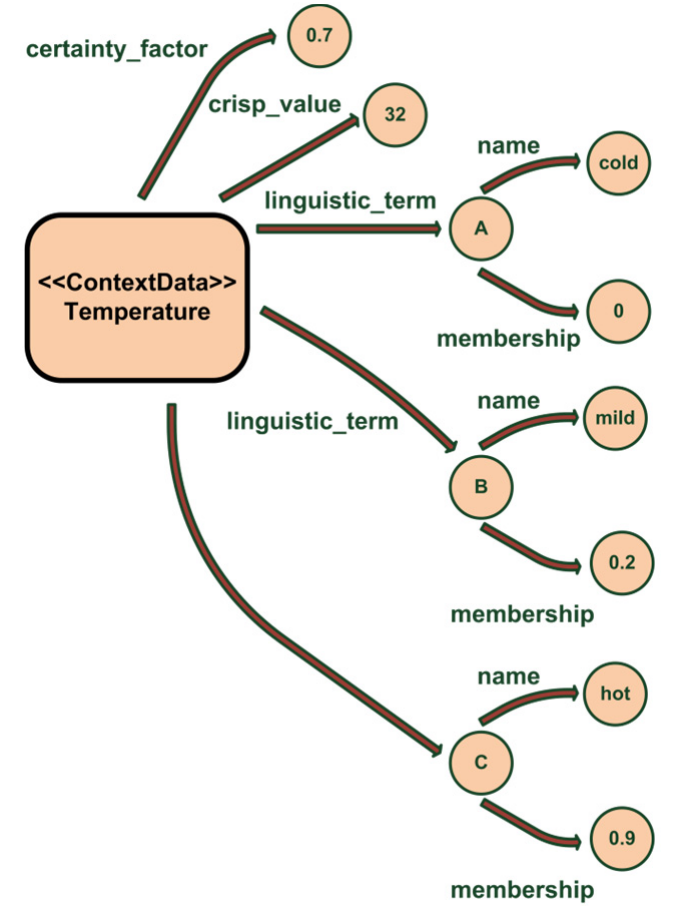
Figure 2. Example of the ambiguity data for a temperature measure stored in the